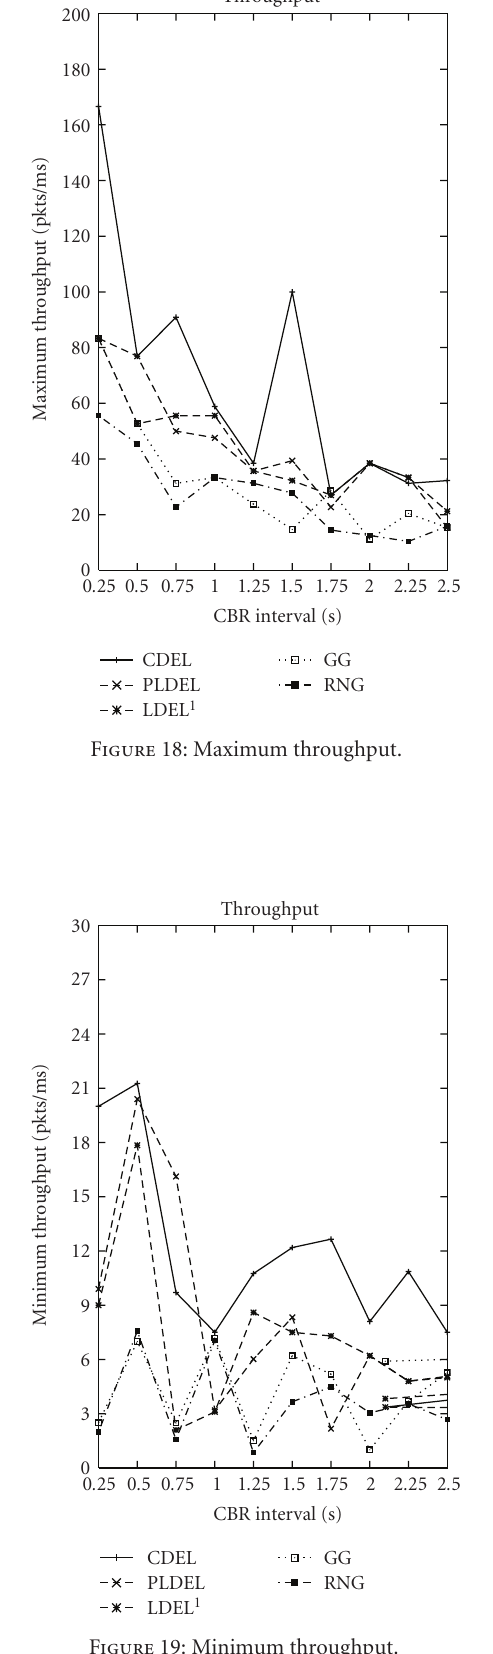
Figure 19: Minimum